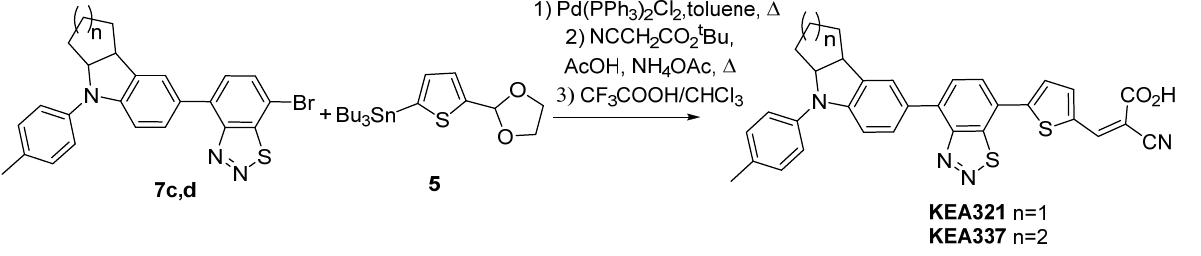
Table 5. UV-Vis absorption characteristics of the KEA dyes, WS-2 , and MAX114